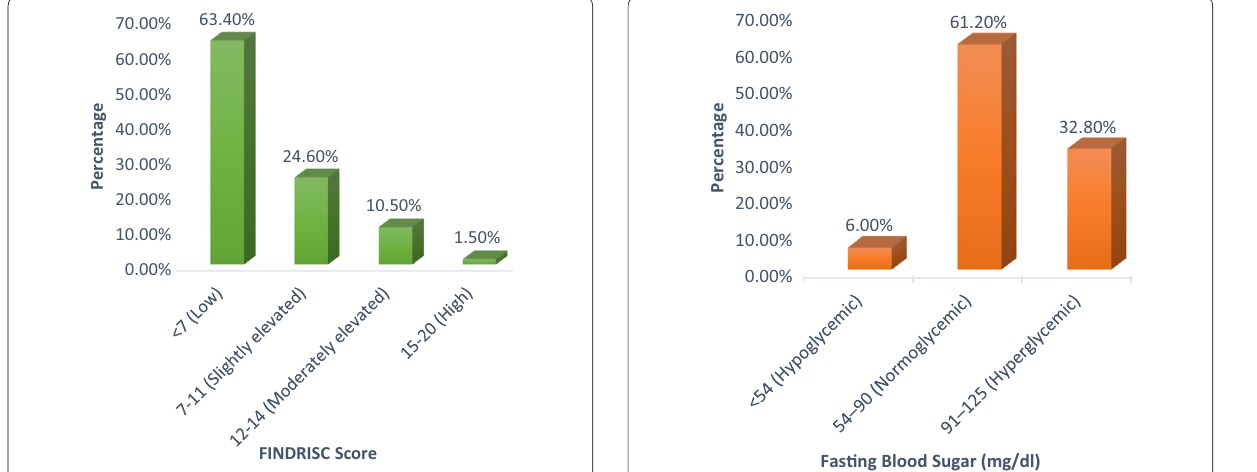
Fig. 1 Distribution of FINDRISC score among participants ( n